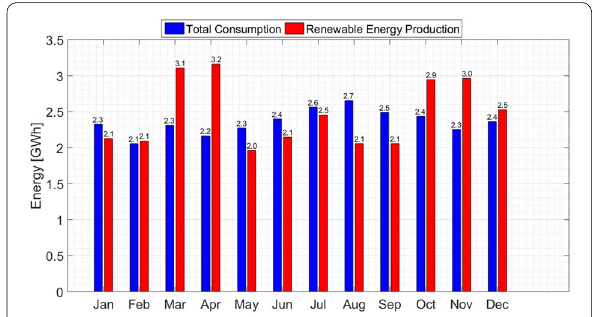
Fig. 13 Estimated total renewable energy emission and monthly consumption for 2018 in São Jorge